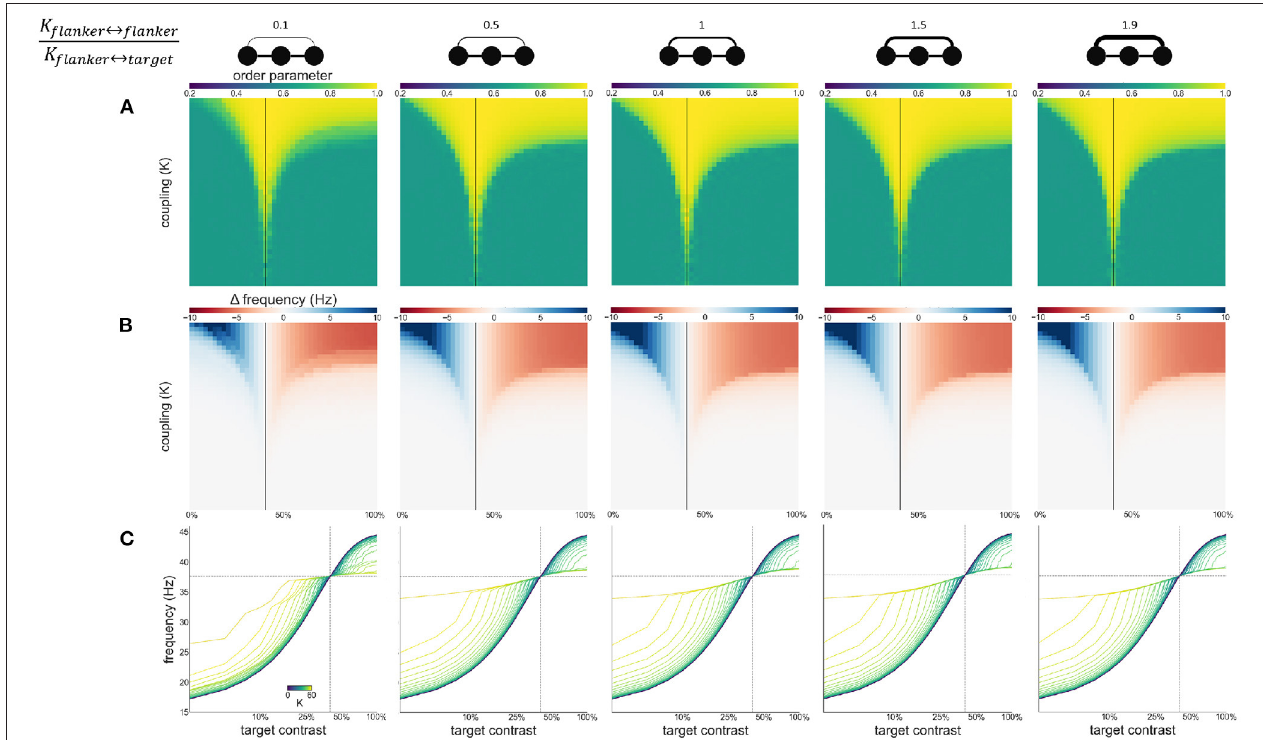
FIGURE 8 | Effects of varying flanker-flanker coupling ratio. Ratio increases from left to right. Ratios are given at the top of the figure together with illustrations of the relevant connections. Formatting of each column is identical to Figure 3 : (A) Arnold tongue (B) difference mean effective frequency and intrinsic frequency of target (C) firing frequency of the